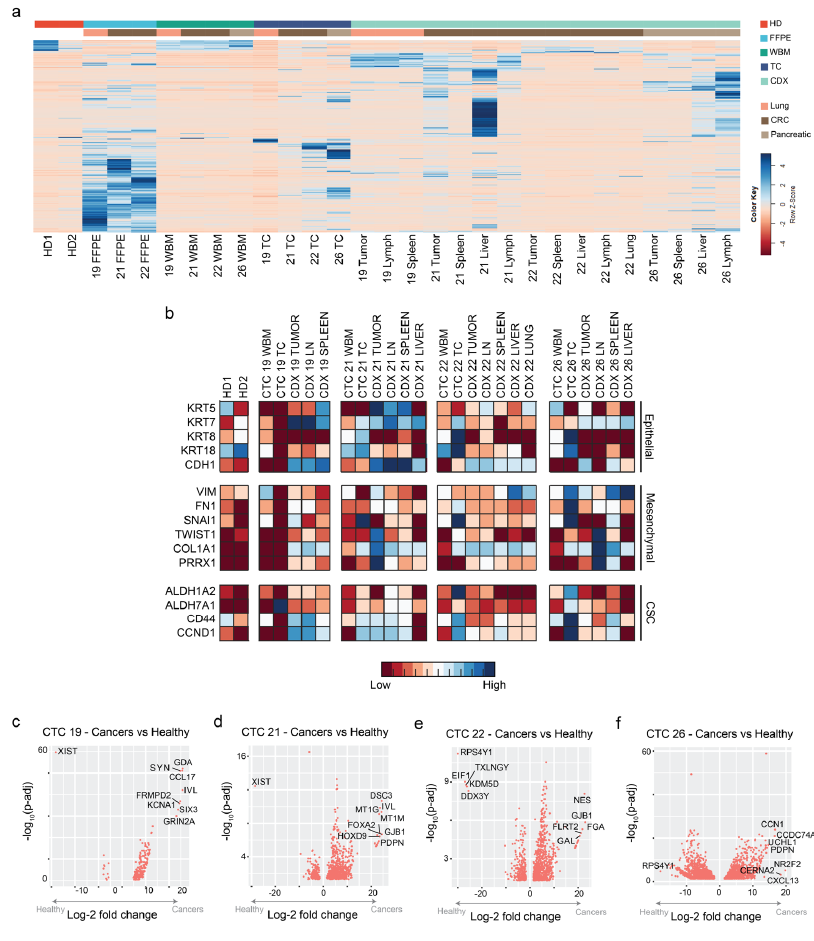
Figure 3. Bulk RNA-sequencing on cultured CTCs and CDX tissues shows transcriptomic heteroge- neity. ( a ) A clustergram depicting mRNA expression in the various samples evaluated. ( b ) A panel of epithelial (KRT5, KRT7, KRT8, CDH1, and EpCAM), mesenchymal (VIM, FN1, SNAI1, TWIST1, COL1A1, and PRRX1), and cancer stem cells (ALDH1A2, ALDH7A1, CD44, and